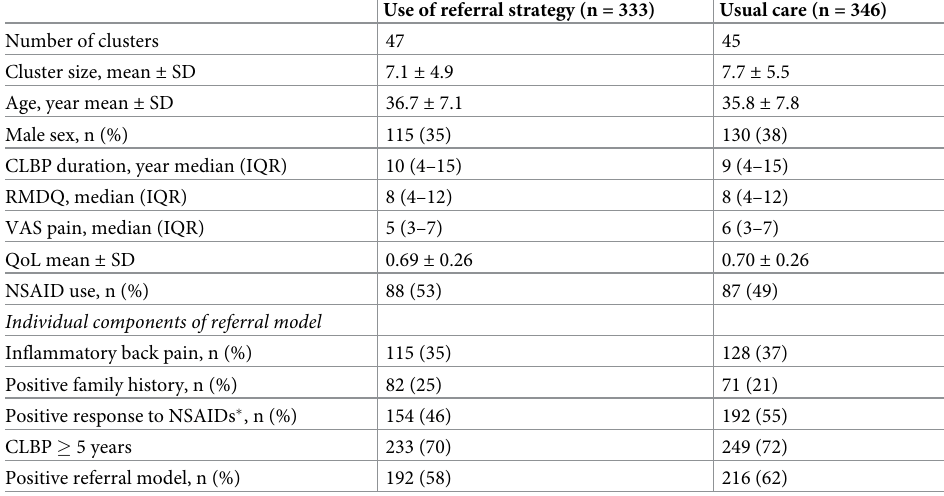
Table 2. Baseline patient